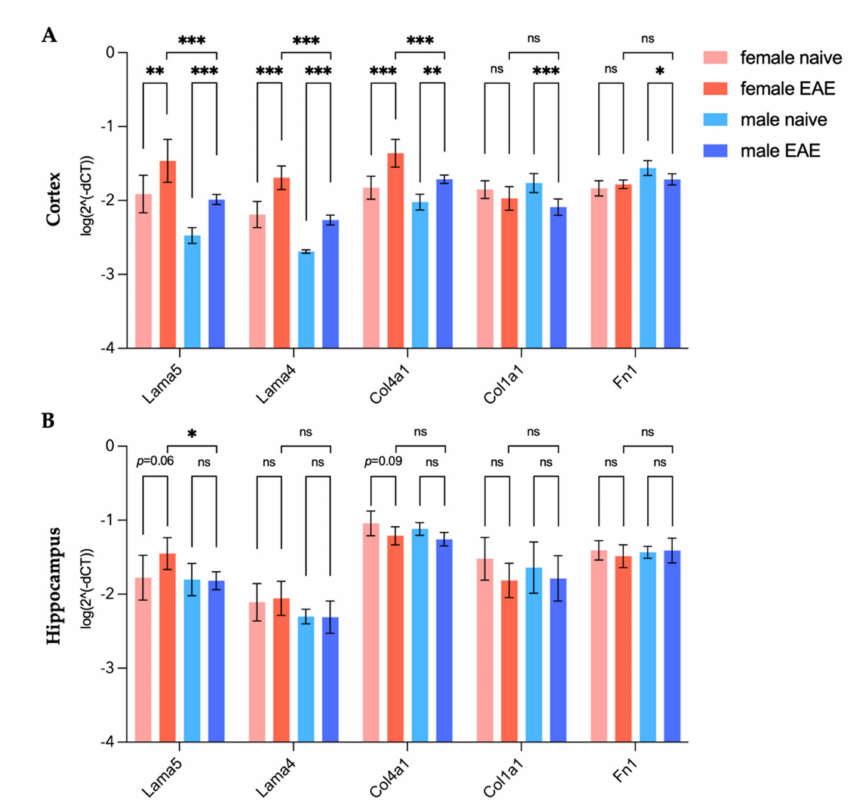
Figure 5. Sex-specific gene expression of ECM targets in healthy and EAE mice in the cortex ( A ) and hippocampus ( B ) relative to endogenous reference Hprt1 . Representation of mean log [2ˆ( − ∆ CT)] with 95% CI. n female naive = 6, n male naive = 6, n female EAE = 6, n male EAE = 7. Two-way ANOVA with Tukey’s post-hoc comparisons. * p < 0.05, ** p < 0.01, *** p < 0.001, ns = not